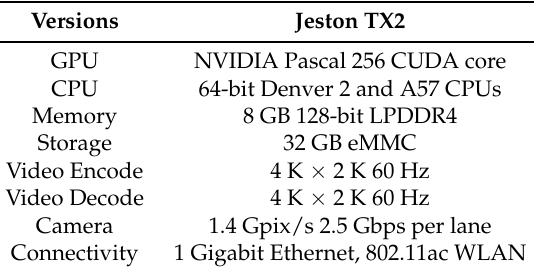
Figure 6. System architecture of ESDR-DL. Table 2. Jetson